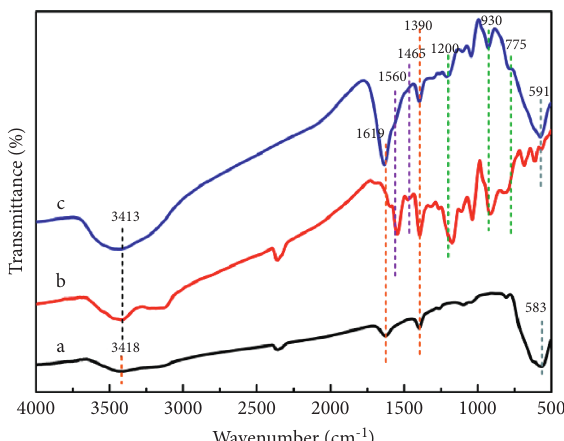
Figure 6: TGA curves of PPy nanotubes, S1, S2, S3, S4, S5, S6, and Fe 3 O 4 3 O 4 (a), PPy nanotubes